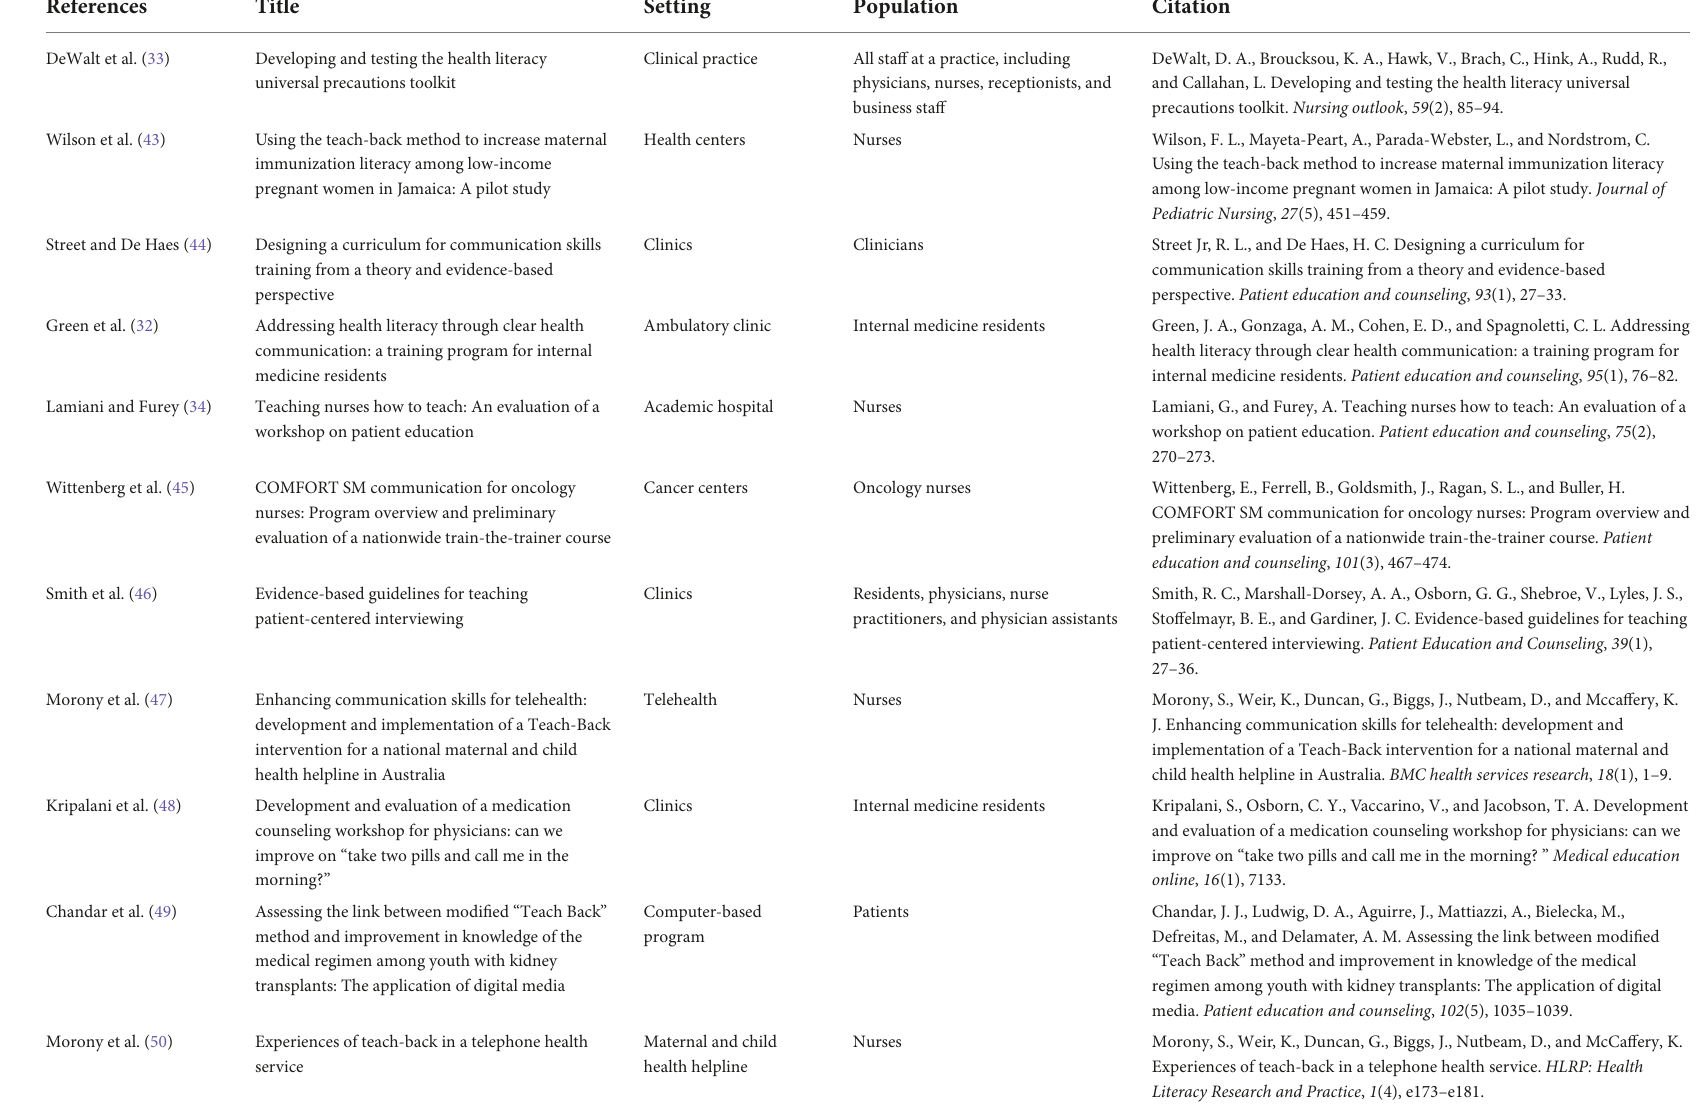
TABLE 1 Identified articles and curricula on Teach